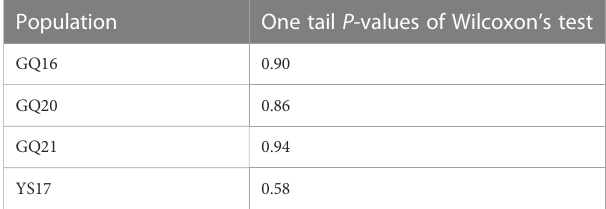
TABLE 5 One tail probability values of Wilcoxon ’ s tests for H e excess across 10 microsatellite loci in four native populations of Undaria pinnati fi da from China.